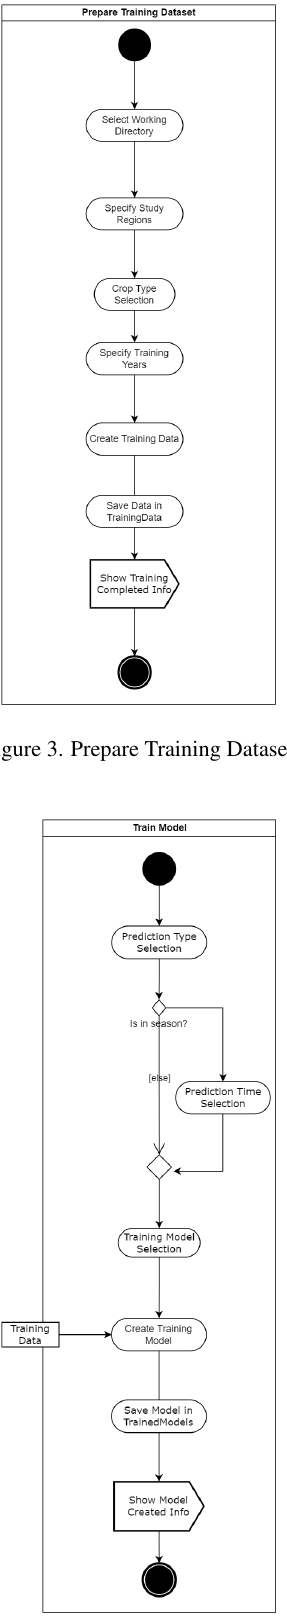
Figure 4. Train model.